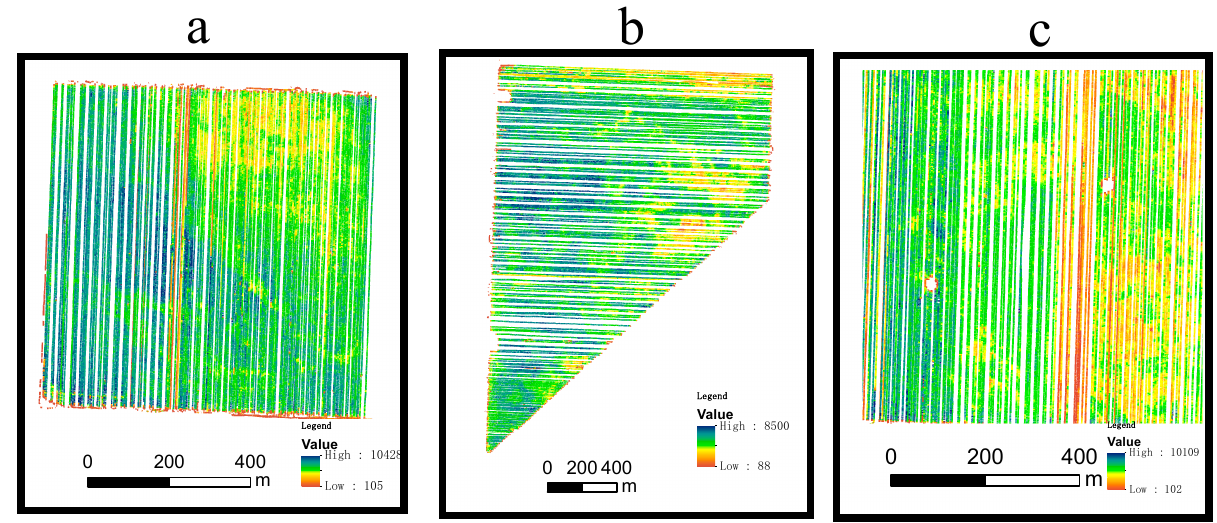
Figure 2. Cotton yield map (2002) of the study plots ( a ) plot A; ( b ) plot B; ( c ) plot C.